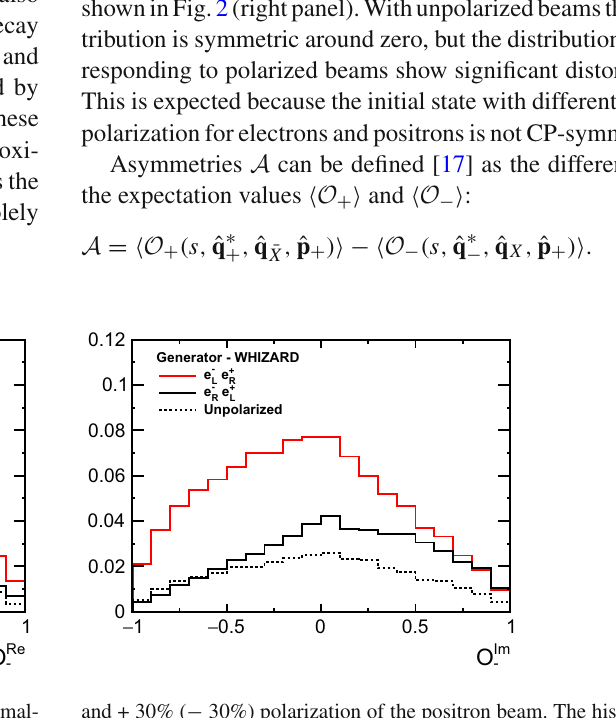
and + 30% ( − 30%) polarization of the positron beam. The histogram for LR polarized beams is normalized to unit area. The area of the other histograms is scaled so as to maintain the cross-section ratios. The O Re ± distribution is confined to [ − 1, 1] by construction, the O Im ± distribution is truncated to the same